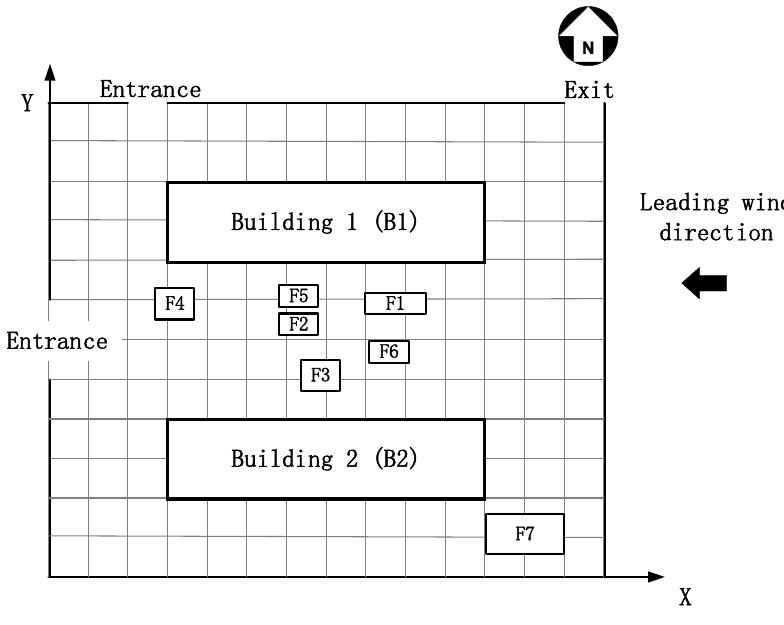
Figure 5. The optimized construction site layout plan.